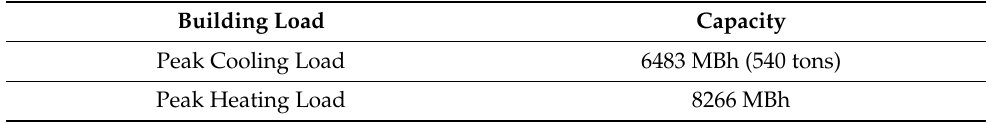
Table A5. Summary Heating, Ventilation, and Air-Conditioning (HVAC) Load table for Ground Source Heat Pump study of CSU’s Moby Arena used to determine a cost premium metric ($/kW) for installation of a heat pump system relative to a conventional heating and cooling system.